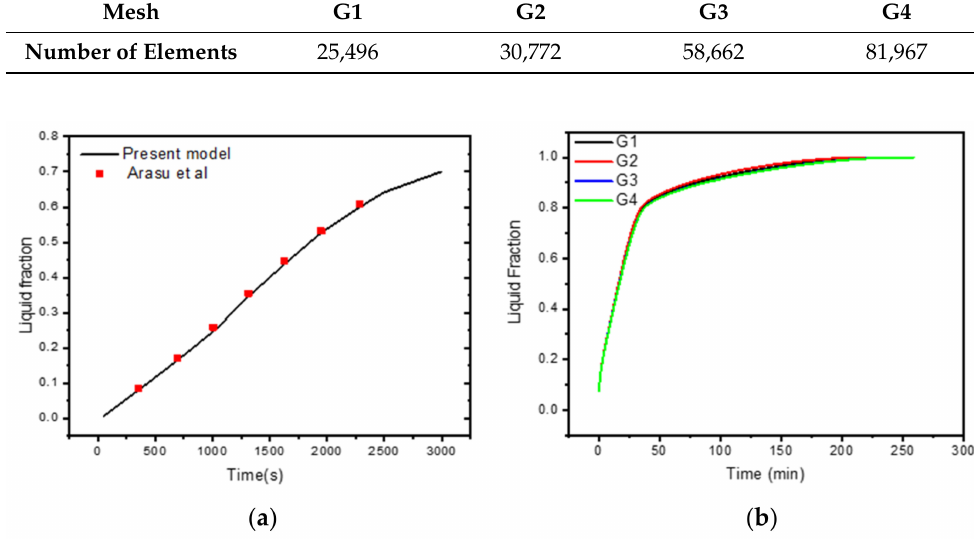
Figure 3. ( a ) Comparison of numerical results with [52]; ( b ) grid independent